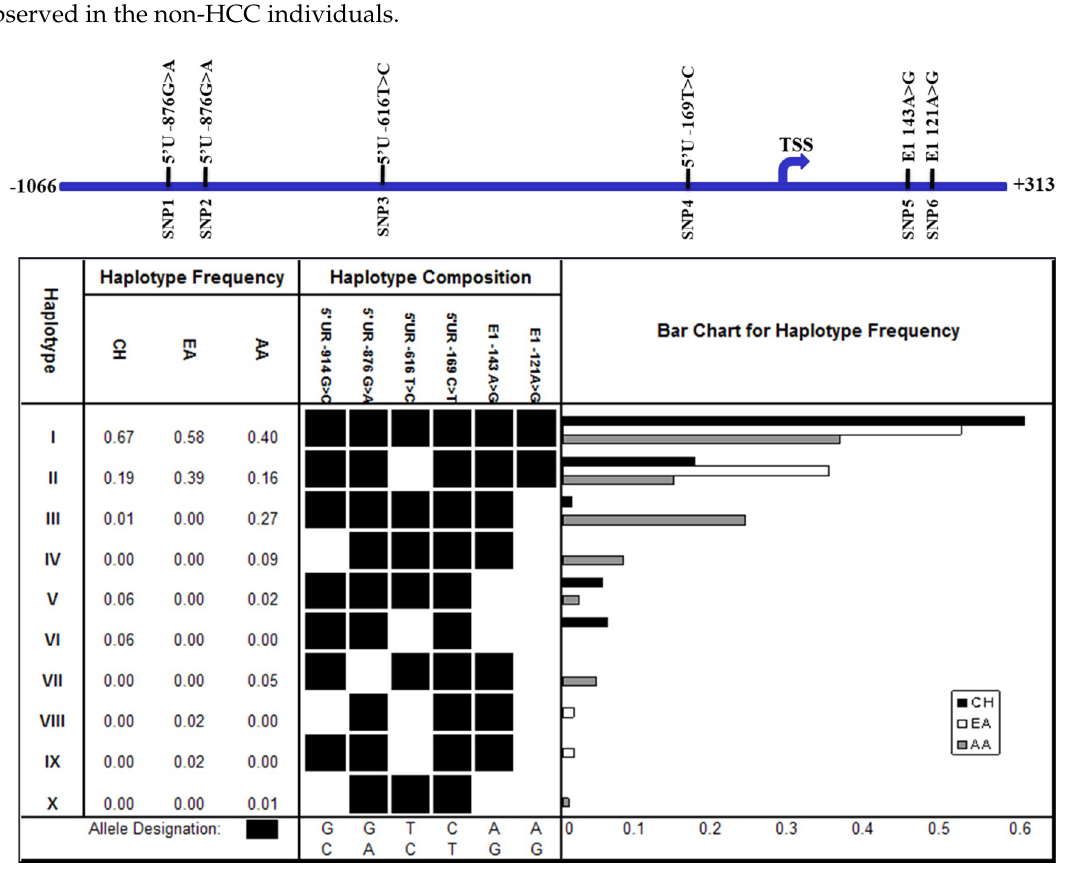
Figure 3. Haplotype of SNPs at the FAT10 promoter region in three ethnic populations. The six single nucleotide polymorphisms are schematically represented at the top panel. TSS: transcription start site. The frequencies of the haplotype of SNPs at the FAT10 promoter region as predicted in silico are shown at the lower panel. CH: Chinese, EA: European‐American, and AA: African‐American.